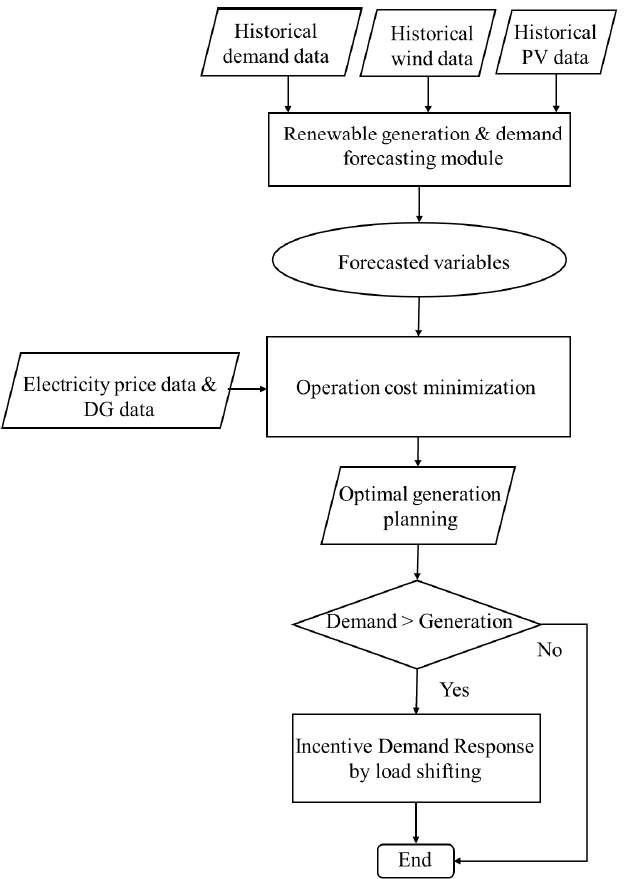
Figure 2. Flowchart for implementation of the proposed decentralized energy management